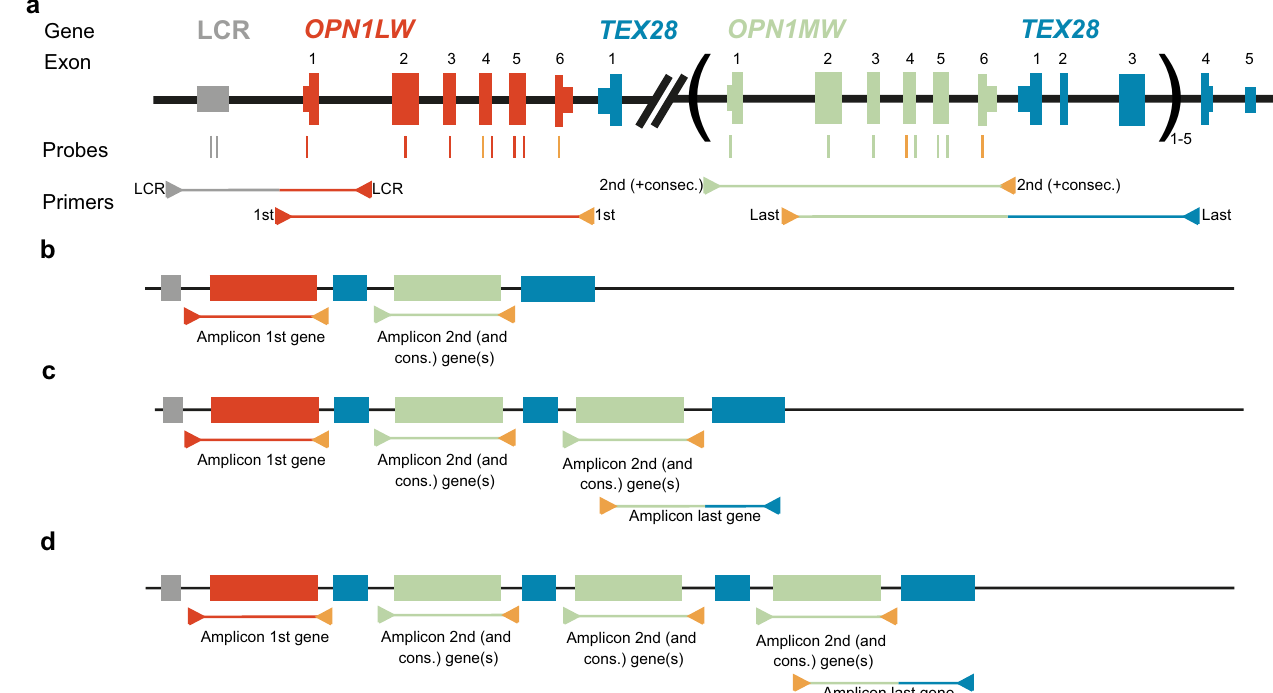
Fig. 1 Schematic overview of the OPN1LW / OPN1MW gene cluster and the position of the MLPA probes and sequencing primers. a The OPN1LW / OPN1MW gene cluster consist of the LCR, one OPN1LW gene and one to fi ve OPN1MW genes. Downstream of the OPN1 cluster, the TEX28 gene is located. MLPA probes are depicted as bars, probes speci fi c for the LCR, speci fi c for OPN1LW or speci fi c OPN1MW are depicted in gray, red or green respectively and probes targeting both OPN1LW and OPN1MW are depicted in orange. Sequencing primers are depicted as arrows, forward primers point to the right and reverse primers point to the left. Primer(s) binding in the LCR, OPN1LW , OPN1MW or TEX28 are depicted in gray, red, green or blue respectively. Primers that can bind to both OPN1LW and OPN1MW are depicted in orange. b If the OPN1LW/ OPN1MW gene cluster has two genes, OPN1LW will be sequenced with the amplicon for the fi rst gene and OPN1MW will be sequenced with the amplicon for the second and consecutive genes. c If the OPN1LW/OPN1MW gene cluster has three genes, OPN1LW will be sequenced with the amplicon for the fi rst gene and both OPN1MW genes will be sequenced with the amplicon for the second and consecutive genes. An additional amplicon was developed for the last gene, in this case the third gene. When the genetic composition of this last third clinically irrelevant gene is determined, the genetic composition of the clinically relevant second gene can be deduced. d If the OPN1LW/OPN1MW gene cluster has four genes, OPN1LW will be sequenced with the amplicon for the fi rst gene and all three copies of OPN1MW will be sequenced with the amplicon for the second and consecutive genes. In this situation ampli fi cation of the last gene is not useful, as one is unable to differentiate between the clinically relevant second and clinically irrelevant third gene in the